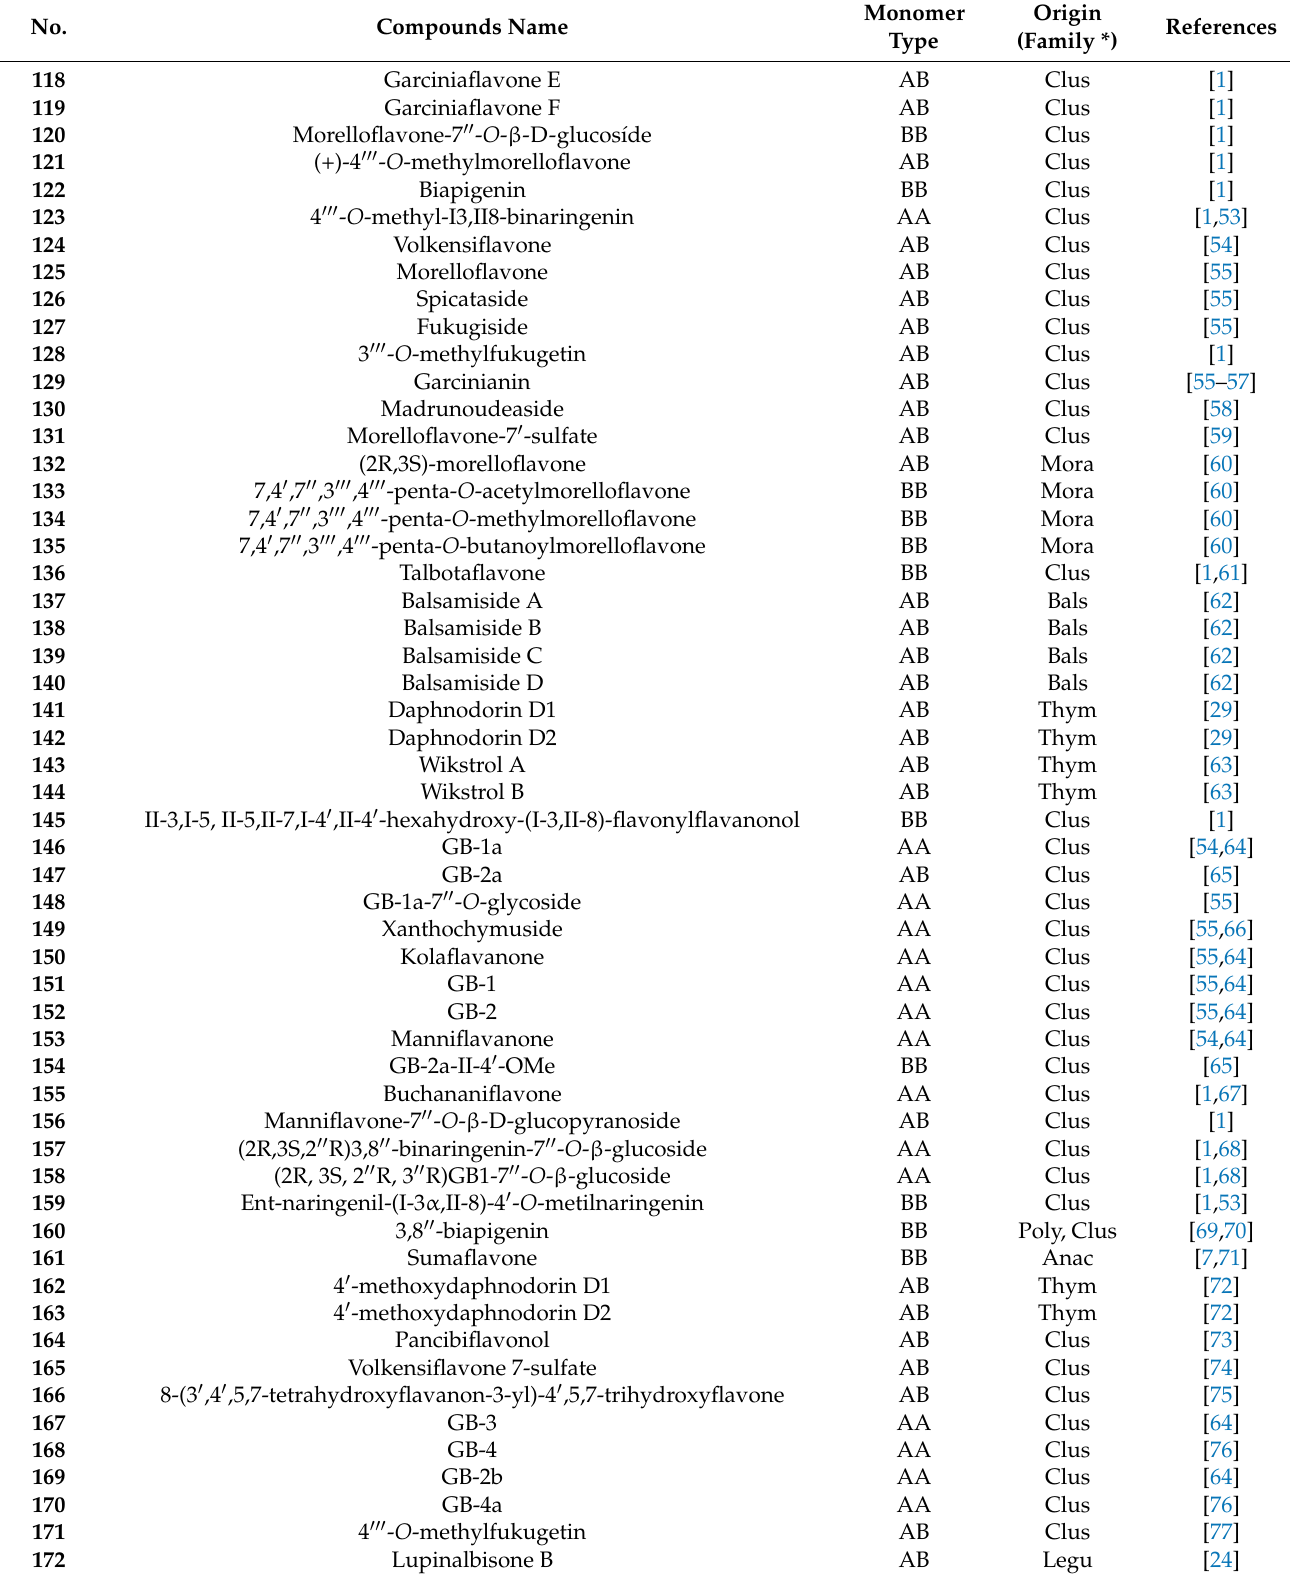
Table 3. The 3-8 (cid:48)(cid:48) subtype of